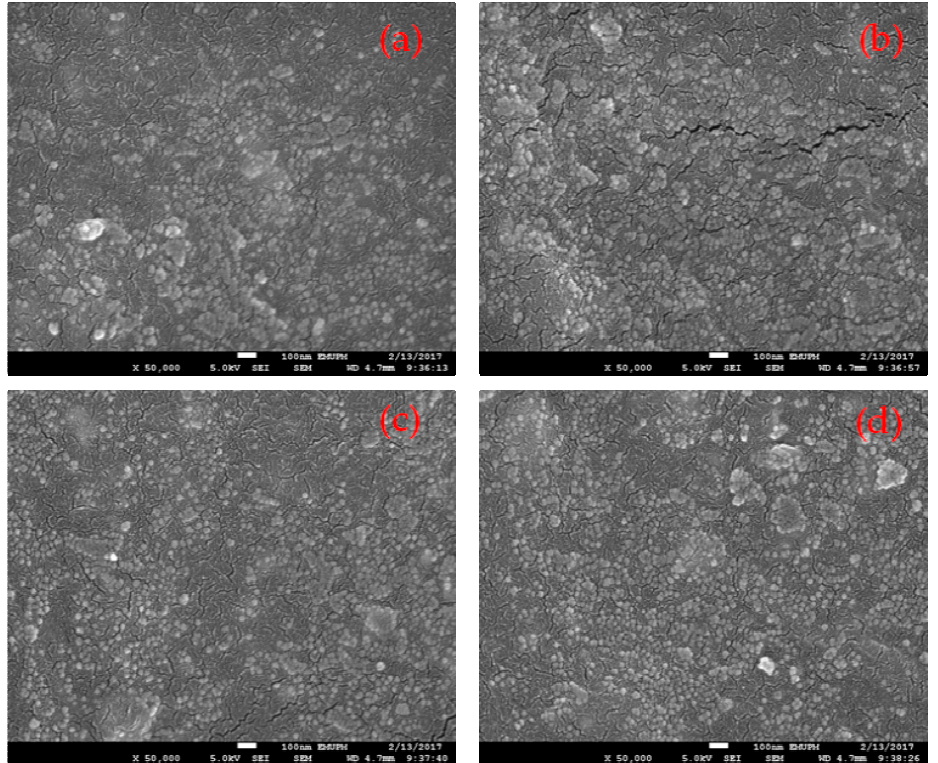
Figure 5. Field Emission Scanning Electron Microscope (FESEM) micrographs of recycled α - Fe 2 O 3 /OPEFB/PCL nanocomposites with ( a ) 5% ( b ) 10% ( c ) 15% ( d ) 20% recycled α -Fe 2 O 3 nanofiller content. OPEFB, Oil palm empty fruit bunch